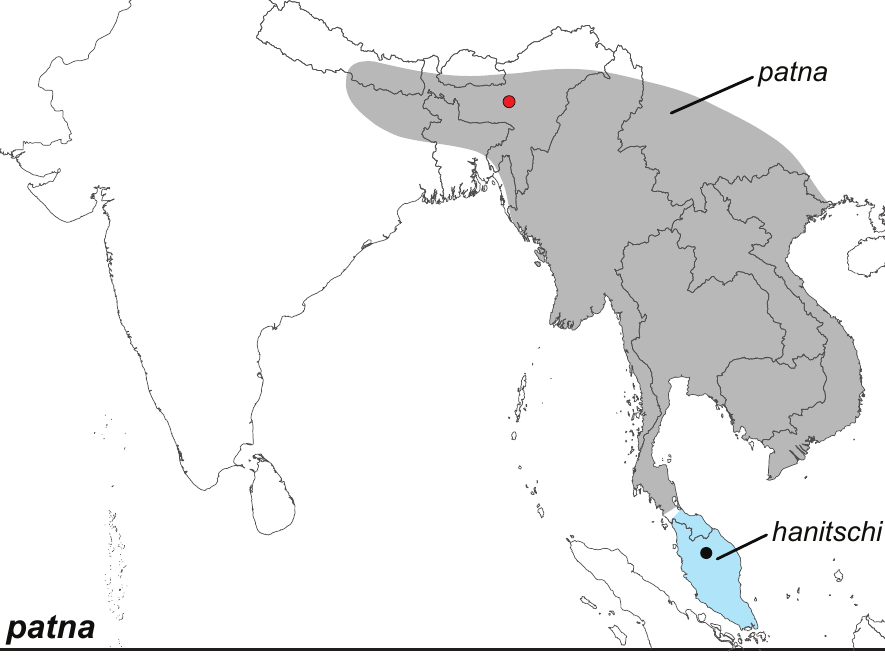
Figure 33. Distribution map of Elymnias patna .